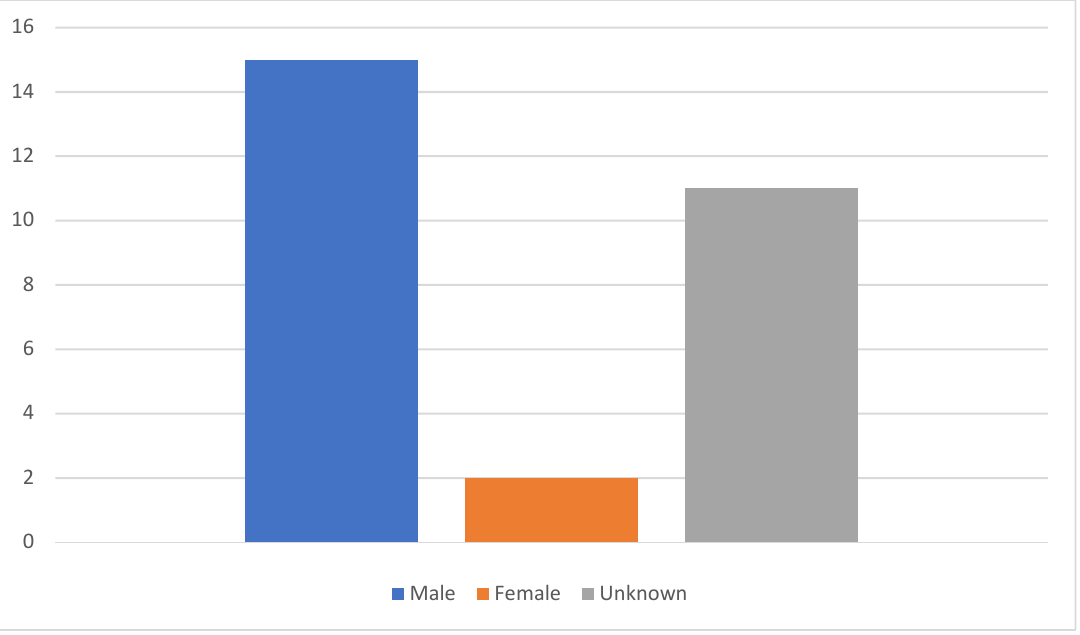
Figure 3. Inferred sex whose tweet was categorized as Code 1: Health Risk. We found that 119 tweets included a link to a webpage. The links included, but were not limited to, podcasts, Instagram, Amazon, and Entertainment and Sports Programming Network (ESPN). Data also showed that 219 tweets included a photo. These photos included gifs, screenshots, photos from the camera roll, etc.